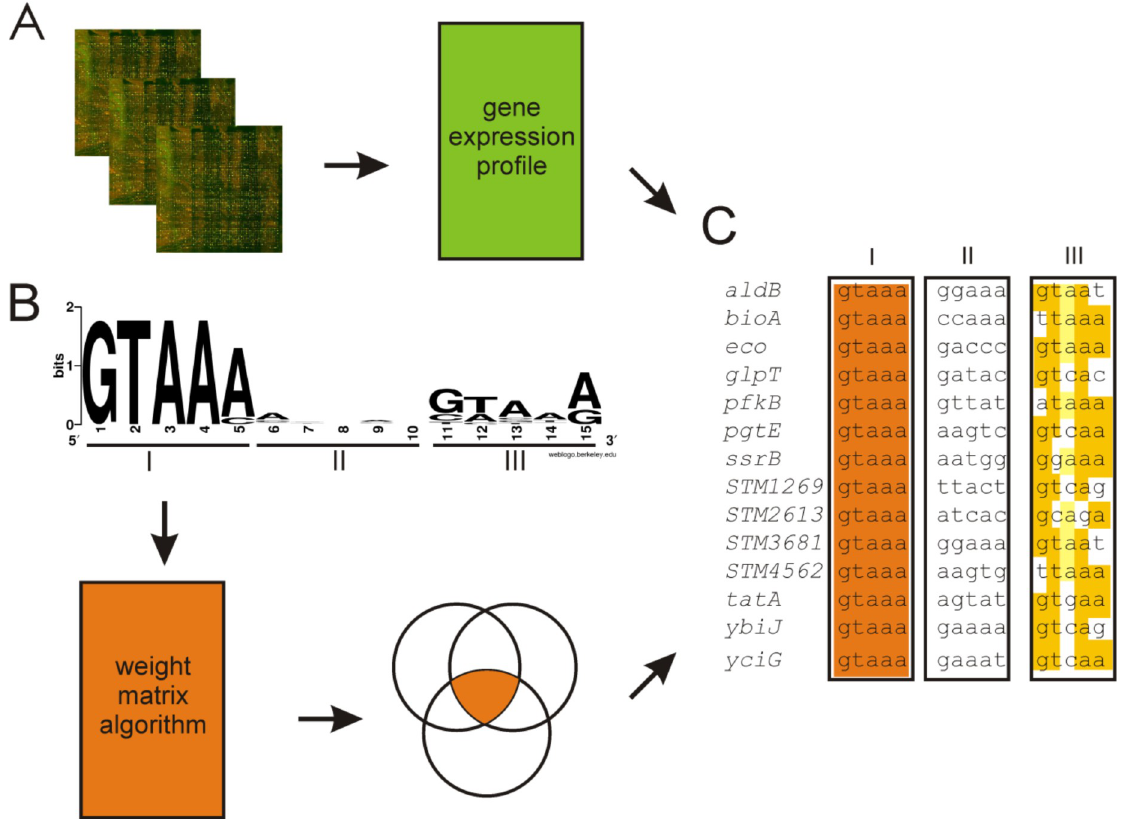
Fig 2. Genome wide identification of novel CpxR dependent genes in S . Typhimurium. A. Global transcriptional analysis was performed by comparing the gene expression profile of a cpxA mutant (SHS01) to a wild-type strain (SL1344) grown under invasion inducing conditions. Genes for which the ratio of the cpxA -null strain to the wild-type strain is e 4 fold with a P value of < 0.005 were clustered using Tibco Spotfire DecisionSite default. B. Bioinformatics-based screening for direct CpxR targets. The sequence logo for the CpxR~P recognition weight matrix in S . Typhimurium is given with the left (I) and right pentamers [28] and the 5-bp spacer marked by roman numerals. The base conservation measured in bits is shown as the relative height of each base [54]. C. Potential novel Cpx regulon members of S . Typhimurium identified by global transcriptional analysis and bioinformatic screening. The left (I) and right [28] pentamers and the 5-bp spacer [28] are displayed as a heat-map to show bases of high conservation (orange) from degenerate regions (light grey/white). The genes controlled by these promoters are indicated to the left of the